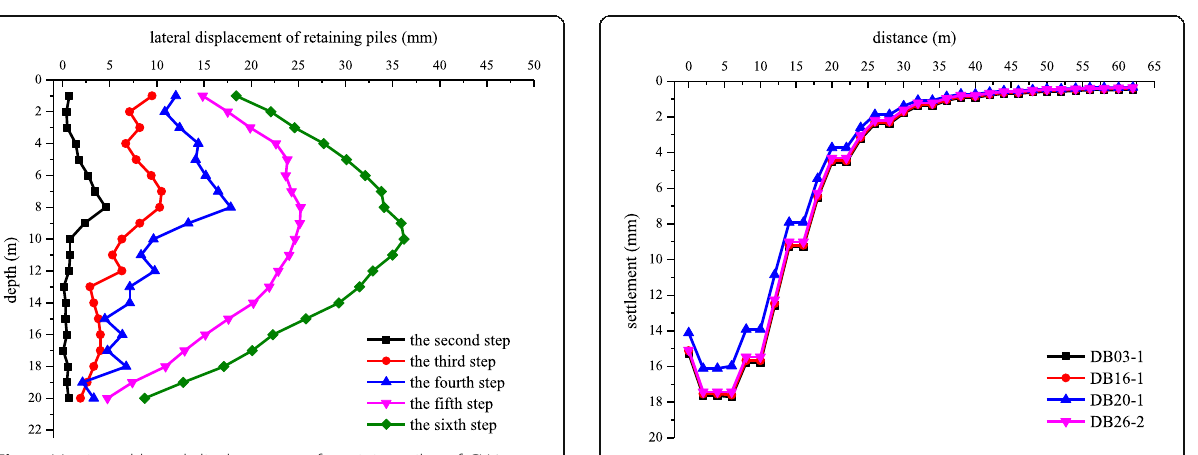
Fig. 8 The simulated settlement around the excavation with the increase of distance